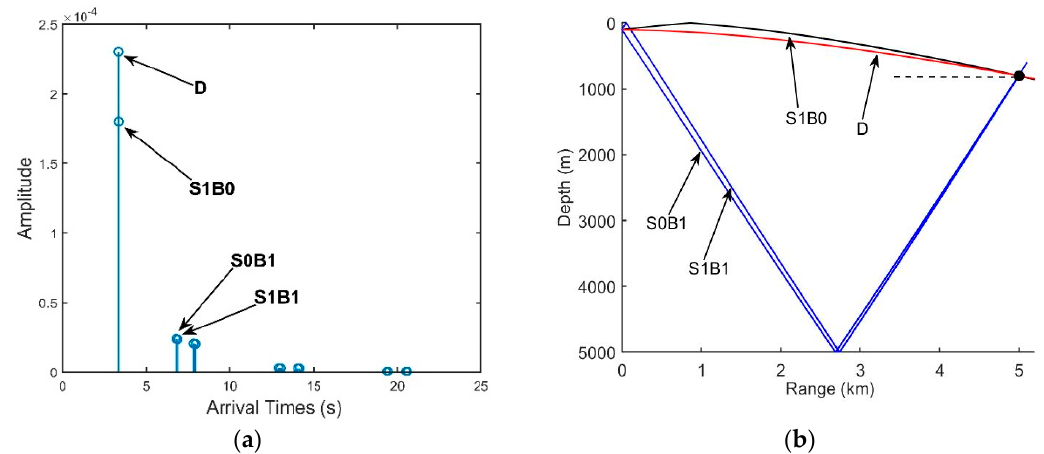
Figure 2. ( a ) Arrival times and amplitudes of the eigenrays and ( b ) Propagation paths of the eigenrays.